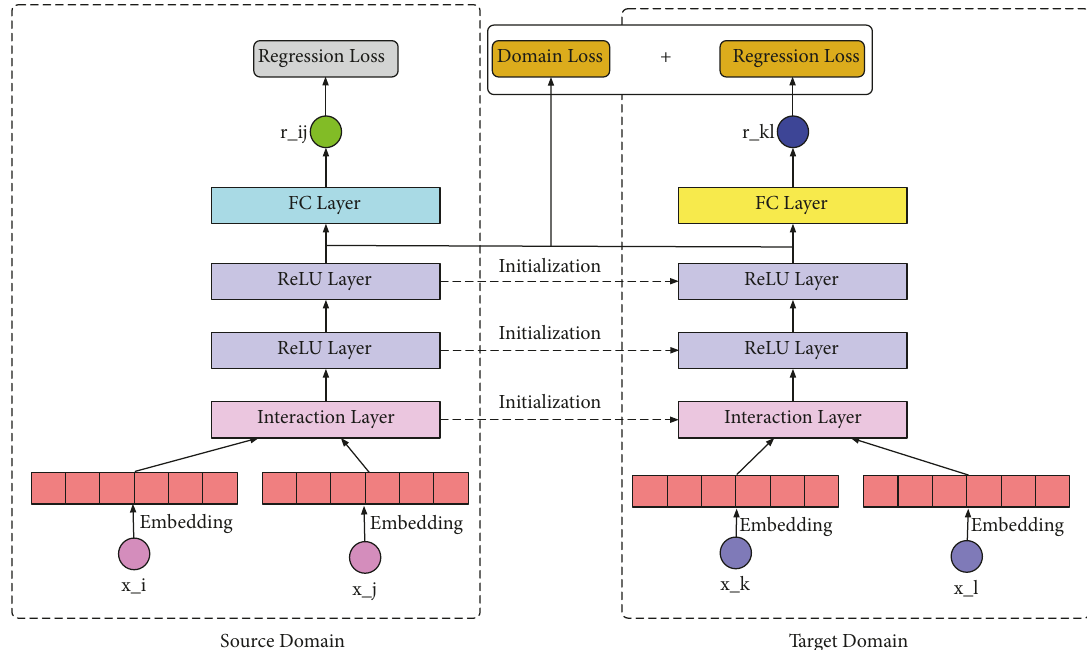
Figure 1: DTCF architecture.